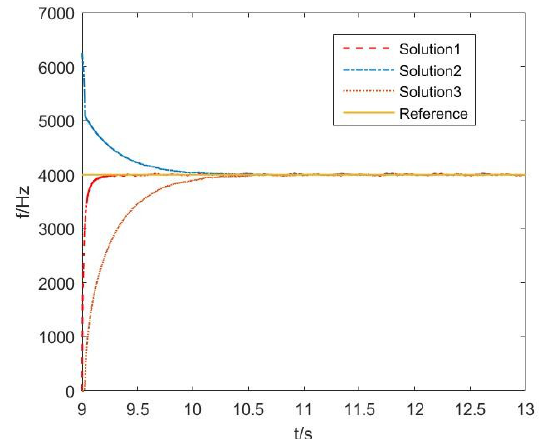
Figure 10. Experiment results of three solutions based on ACLMS algorithm.